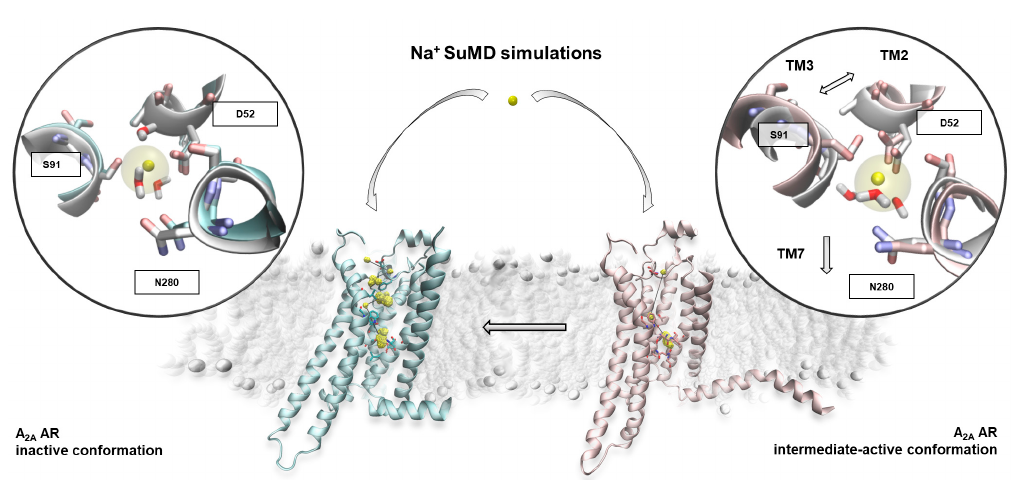
Figure 1. The recognition pathway of Na + on the two relevant A 2A AR conformations. TM = transmembrane helices.